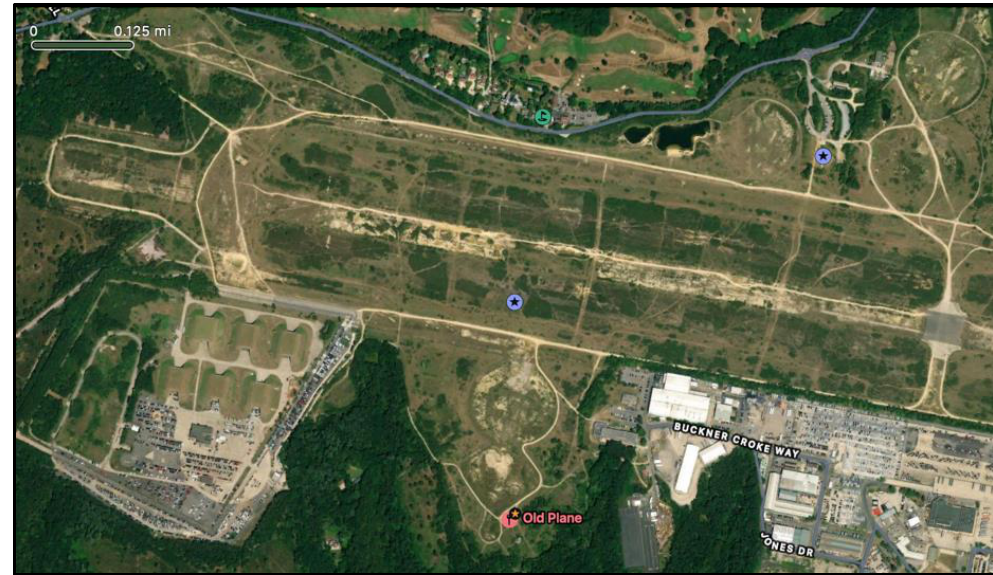
Figure 3. Map of the Greenham Common Airbase test area. (Source: Google Earth Maps).